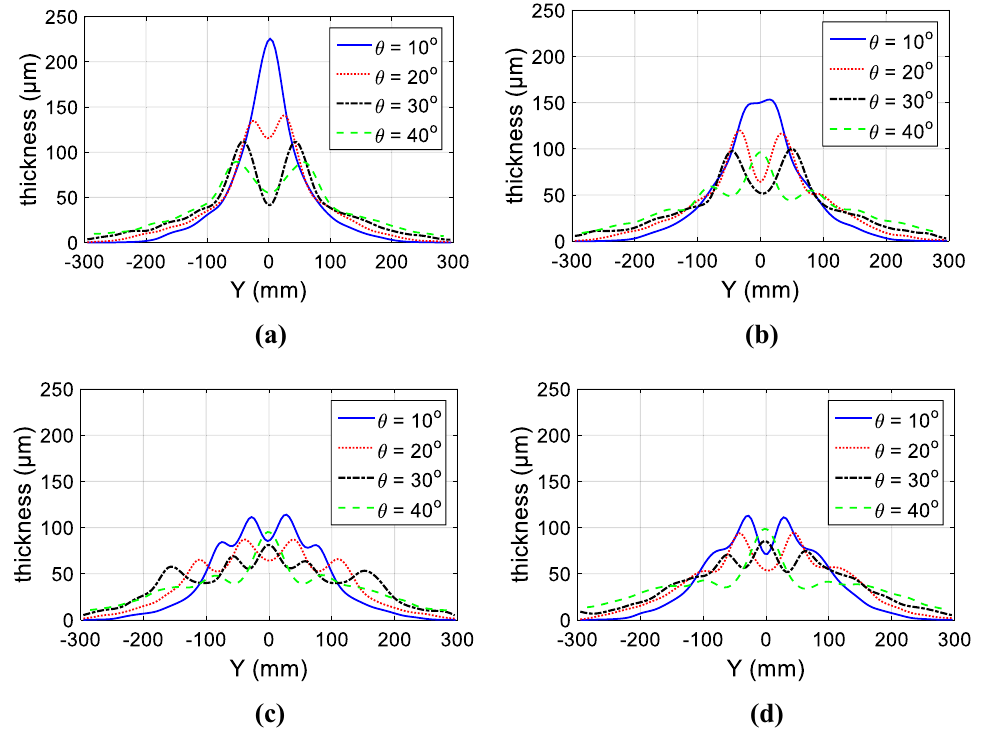
Fig. 10 Coating thickness profiles: a L = 20 mm; b L = 30 mm; c L = 40 mm; d L = 50 mm